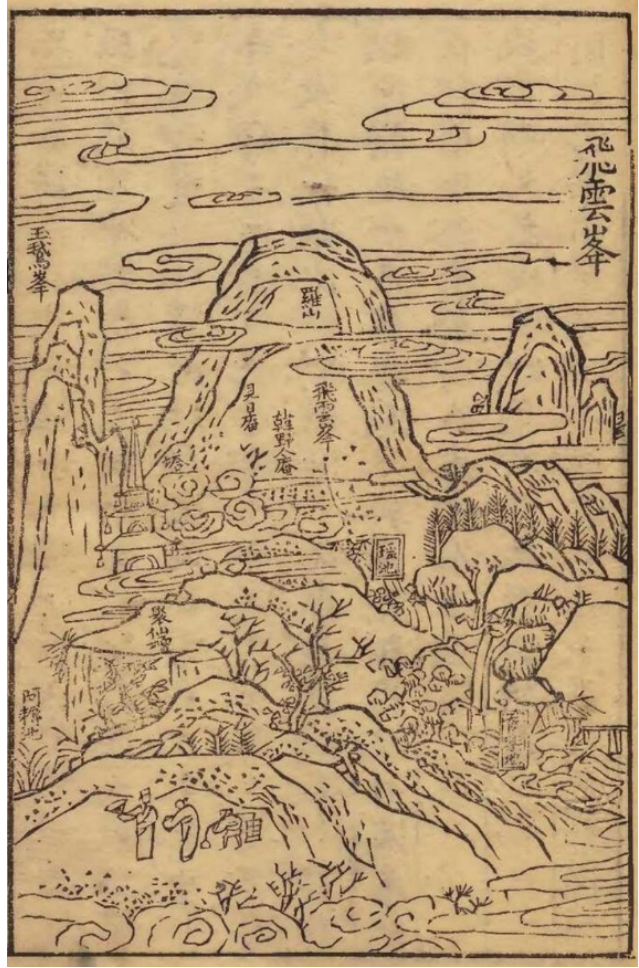
Figure 7. Image of the Feiyun Feng, 1607. Woodblock print. After Han Mingluan, Luofu zhi lue , 1.43a.